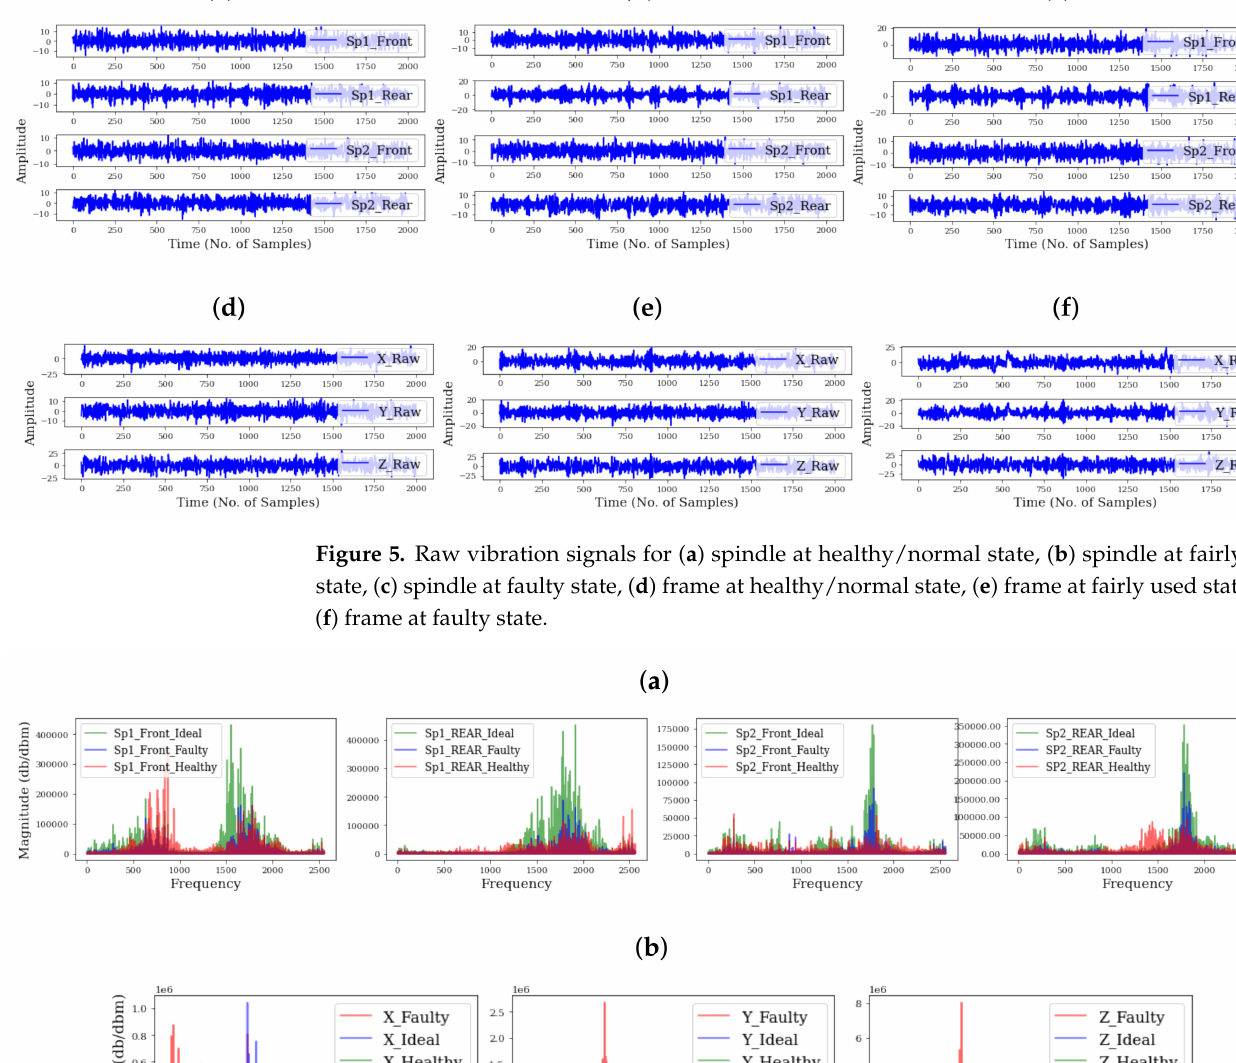
shows their corresponding time-domain signal outputs after the spectral isolation